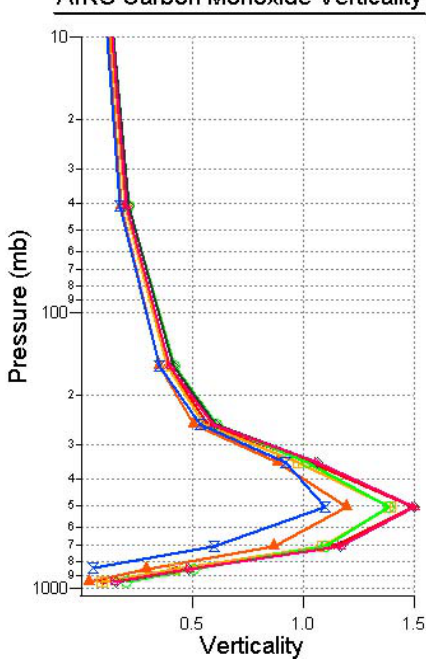
Fig. 7. AIRS carbon monoxide verticality for a few pixels in the Spring of 2010 (separated by color), showing that AIRS has most sensitivity to carbon monoxide in the middle troposphere. When convolving the AIRPACT-3 profiles with the AIRS averaging ker- nels, portions of the convolved profile where verticality is over 1 typically increase, while they decrease where verticality is less than